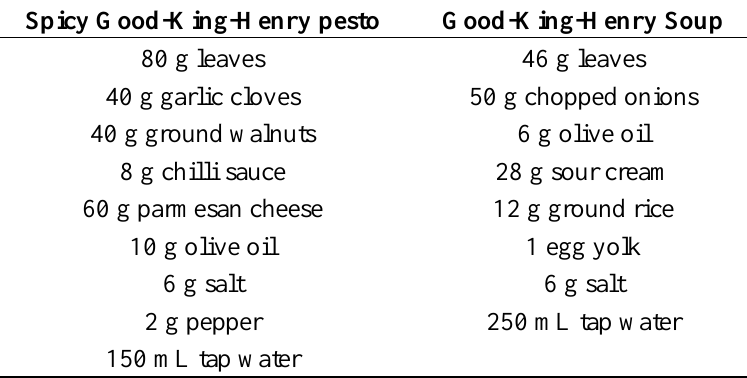
Table 1. Ingredients for Good-King-Henry pesto and soup. Spicy Good-King-Henry